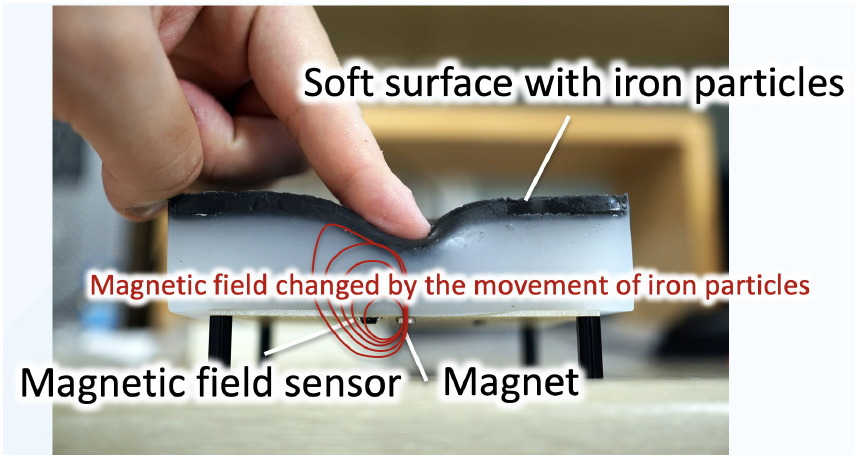
Figure 6. Basic structure of the proposed flexible tactile sensor, which can detect an applied normal force and vertical deformation.